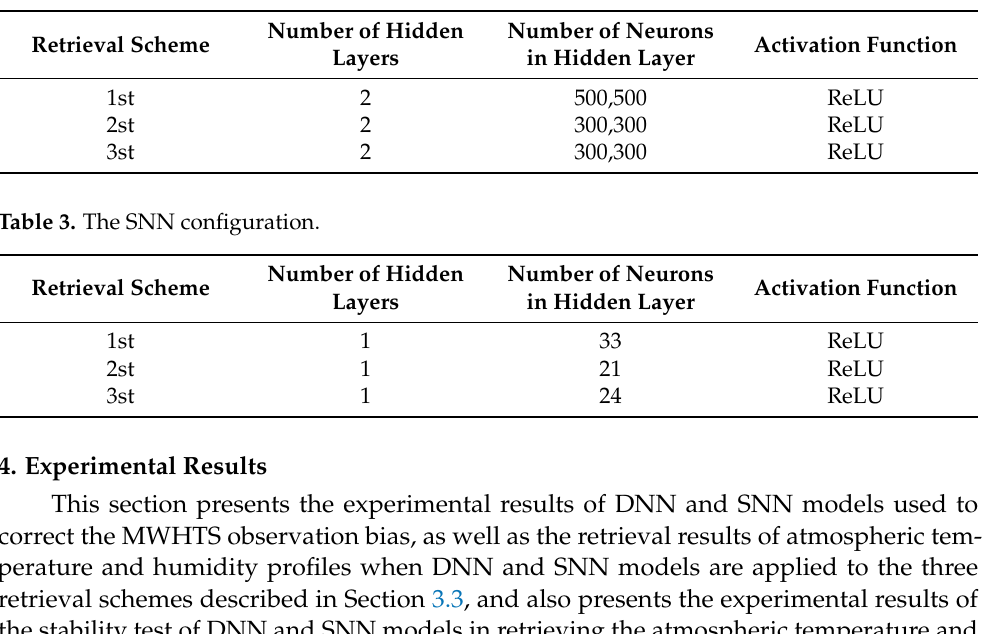
Table 2. The DNN configuration.